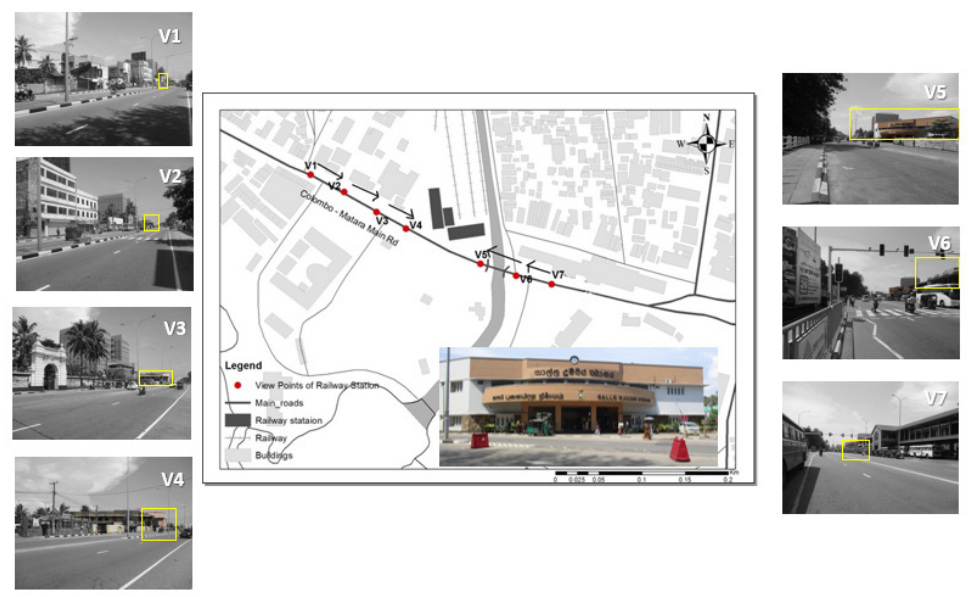
Figure 10. Exemplar demonstration of the view assessment analysis of the Galle railway station